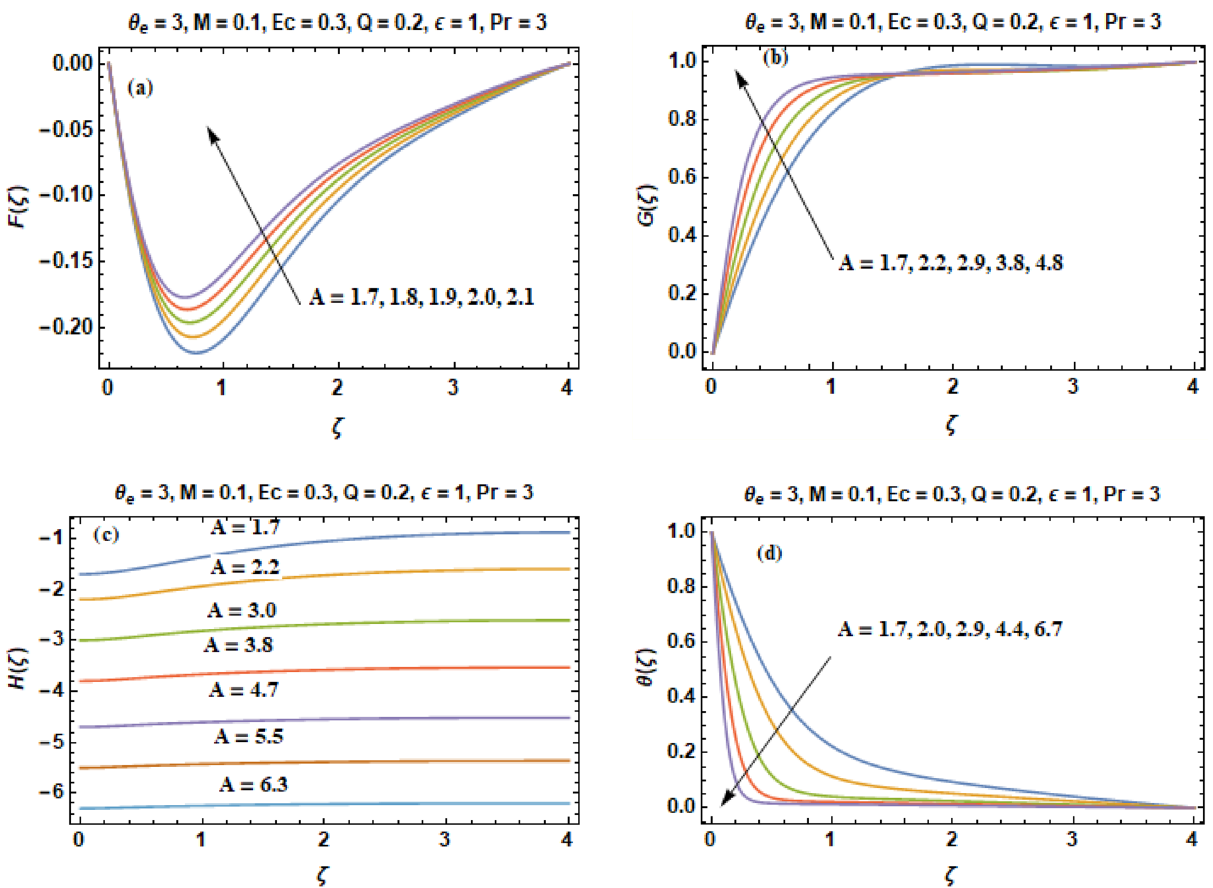
Figure 2. ( a – d ) Components of velocity ( F , G , H ) & temperature curves ( θ ) versus A .